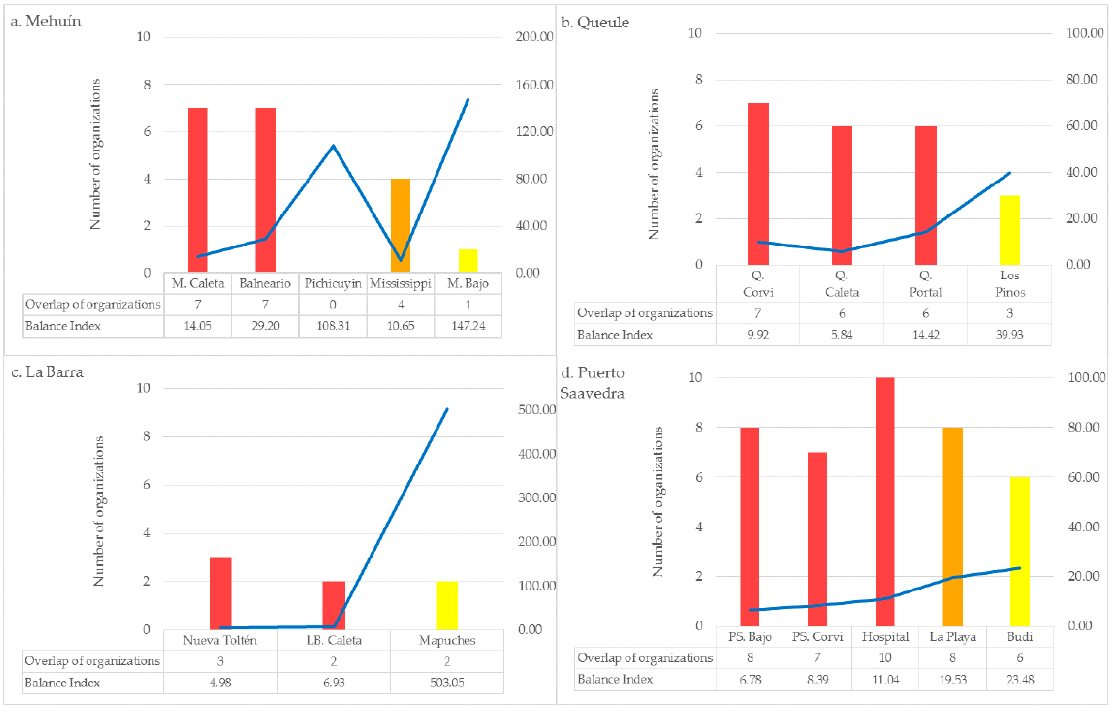
Figure 7. Overlap in governance and balance index. Note: Red, orange, and yellow colors are used to indicate urban, rural, and indigenous sectors respectively.